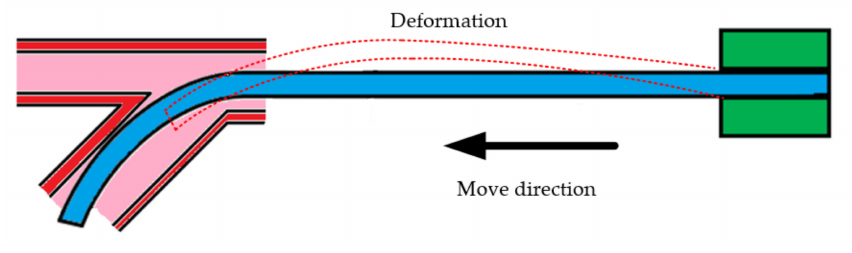
Figure 5. The advance and deformation of a catheter.